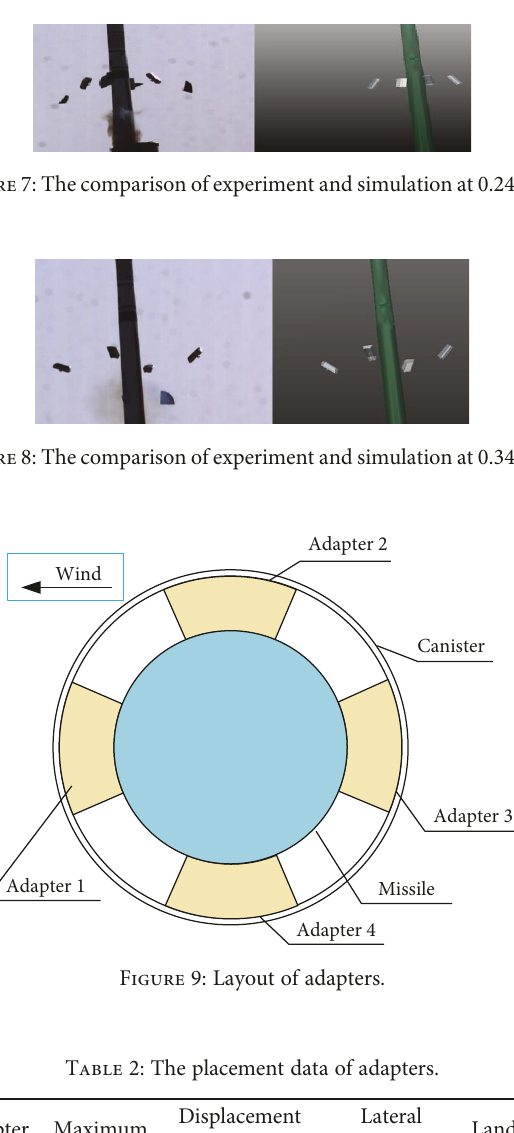
Figure 10: The diagram of adapters ’ placement.